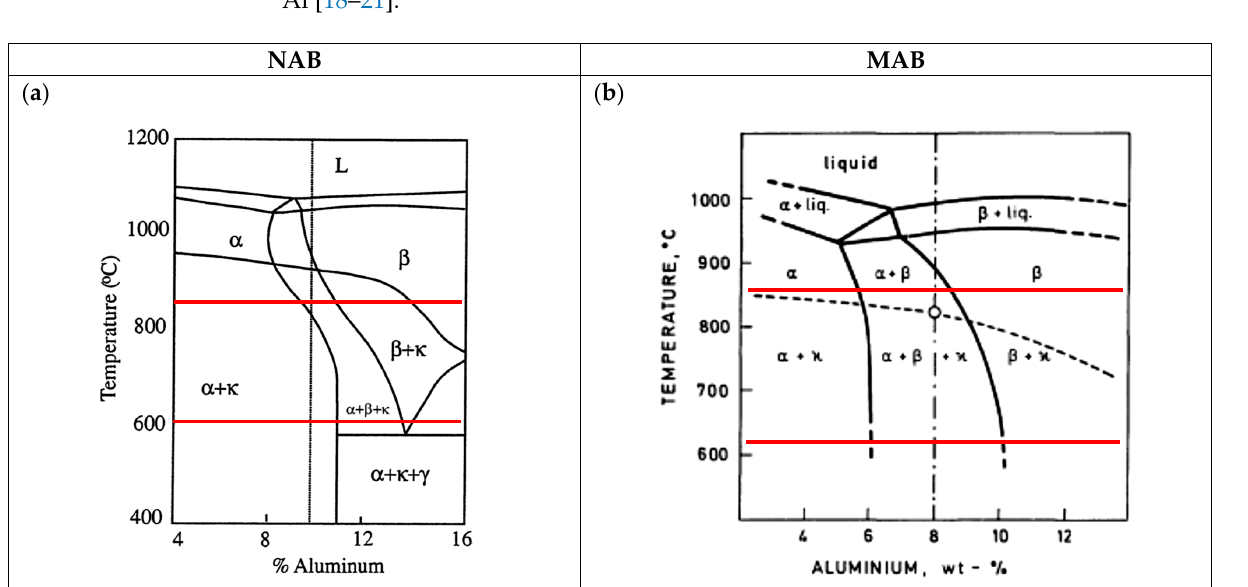
Table 1. Chemical composition of NAB and MAB (wt. %) as provided by the foundry.